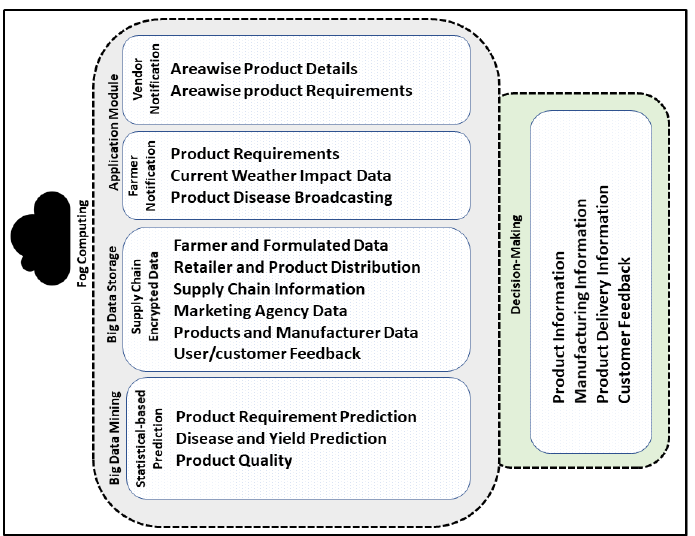
Figure 2. The integration of fog computing into the FogAuth-FT food traceability